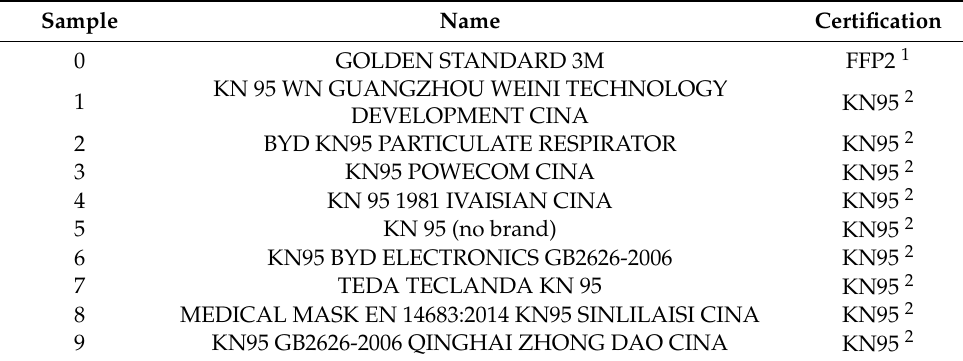
Table 1. Name, sequential sample number, and certification type of each tested device.